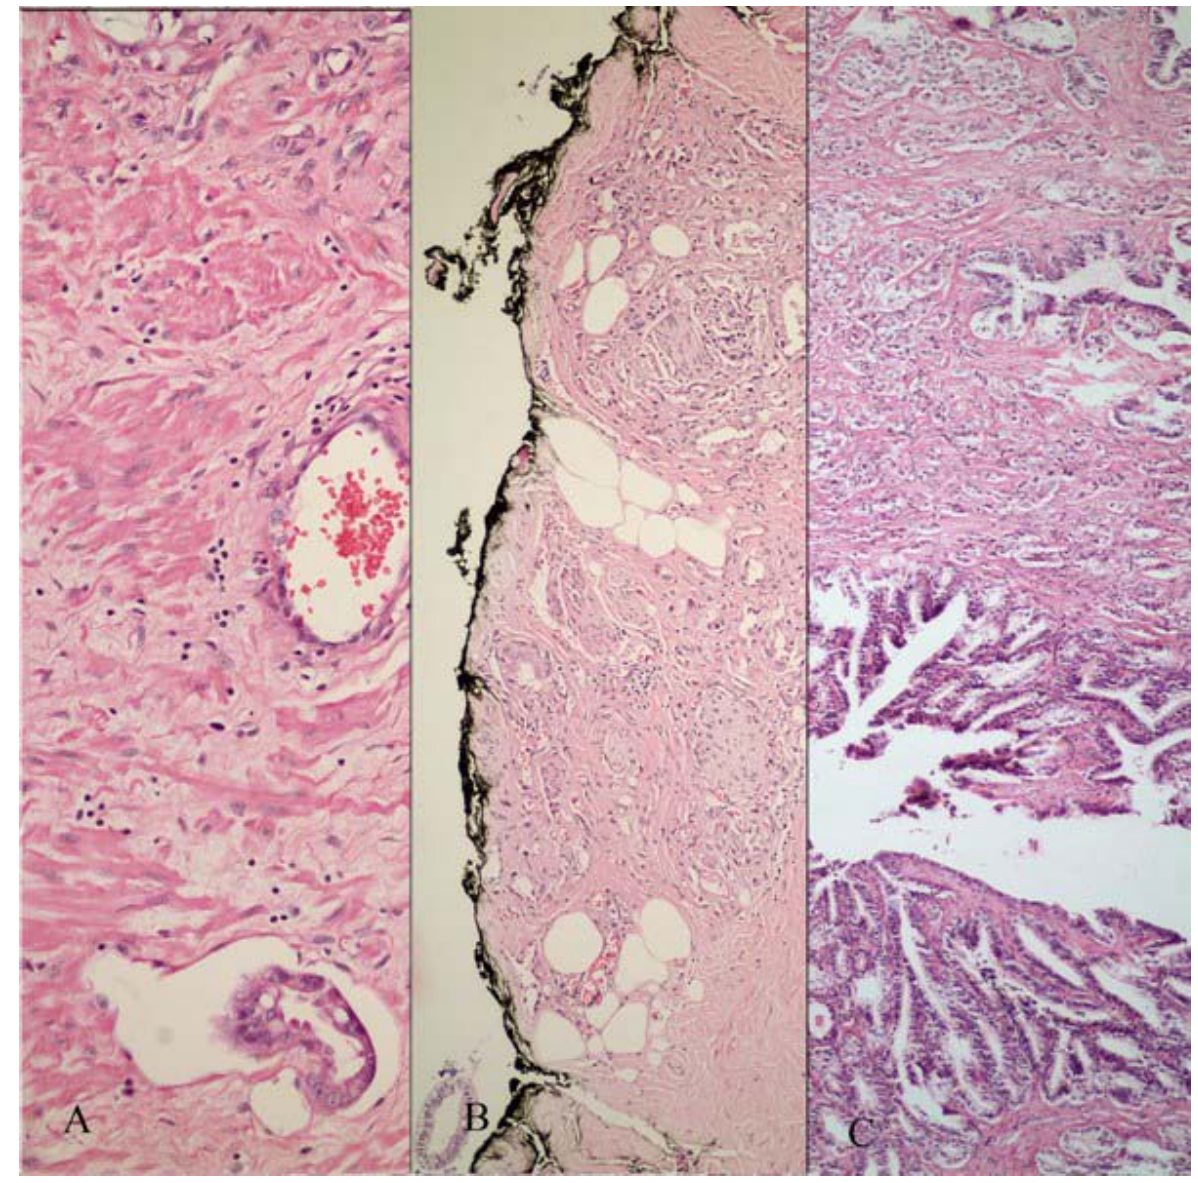
FIGURE 2. A neoplastic gland in a vascular space (A). The same tumor showing extraprostatic extension with positive surgical margins (B) and seminal vesicle invasion (C). (A: H-E × 400, B: H-E × 200; C: H-E × 200).